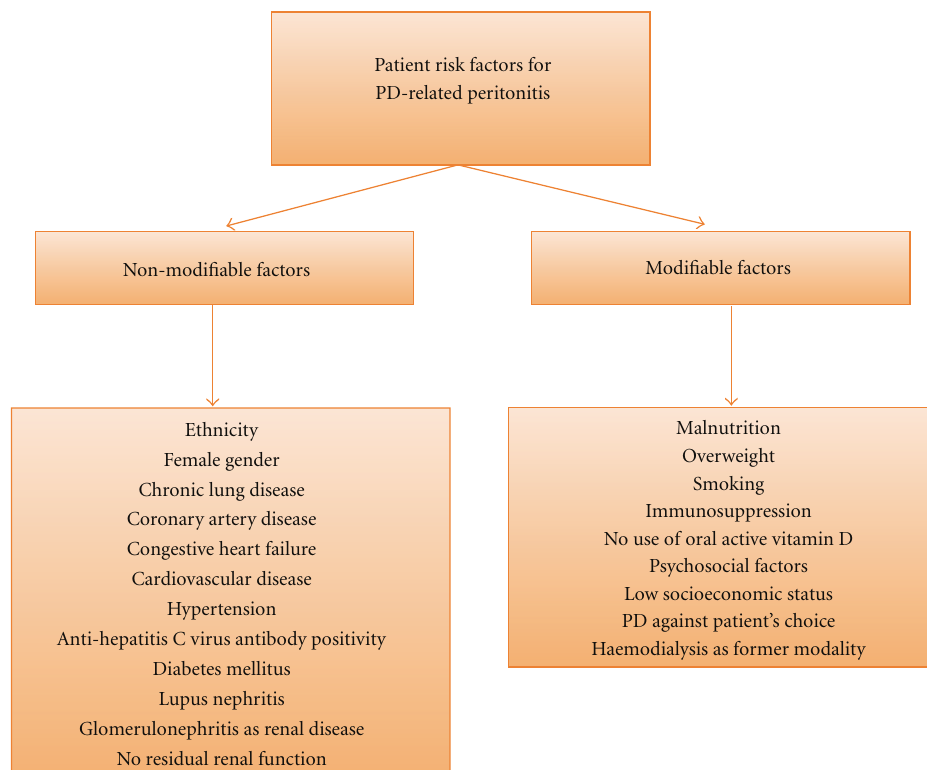
Figure 2: Identified patient risk factors. Factors are divided by nonmodifiable and modifiable risk factors.